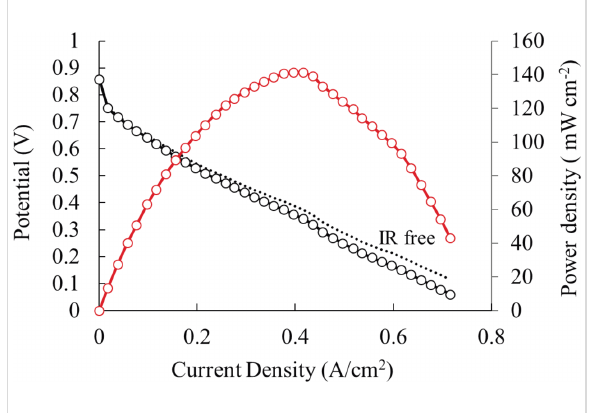
Figure 10: The result of a single-cell test using PH-700 as the cathode catalyst. Current density (black solid line), IR free current density (black dotted line), red solid line (power density).